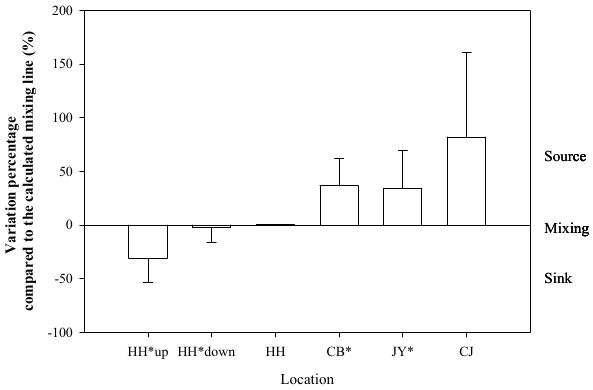
Figure 5. Variation percentage compared to the calculated mixing lines for the HH River, CB River, JY River and their corresponding estuaries of HH and CJ. The percentage >0 represents a source, the percentage <0 represents a sink, the percentage equal to 0 repre- sents a mixing, and * represents a